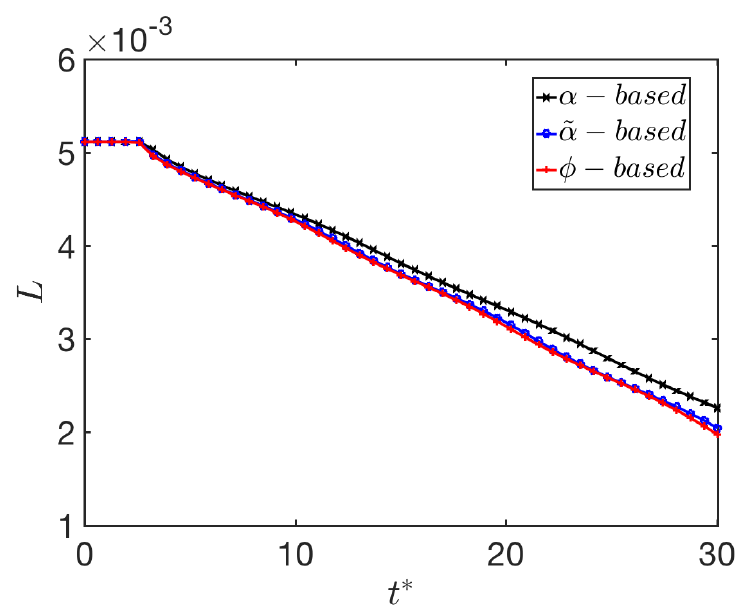
Figure 12. The time evolution of the column length predicted by the different curvature estimation schemes.